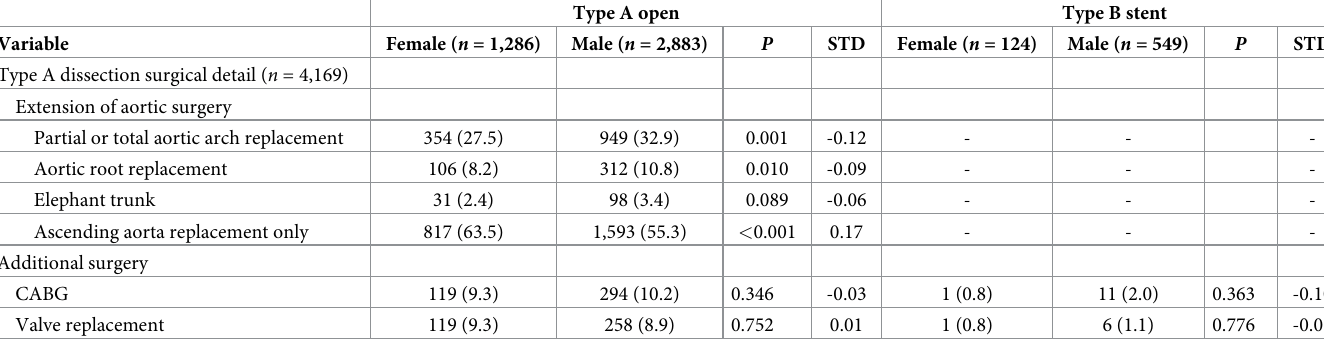
Table 4. Surgical characteristics of the female and male patients who received AAD surgery before propensity score matching.